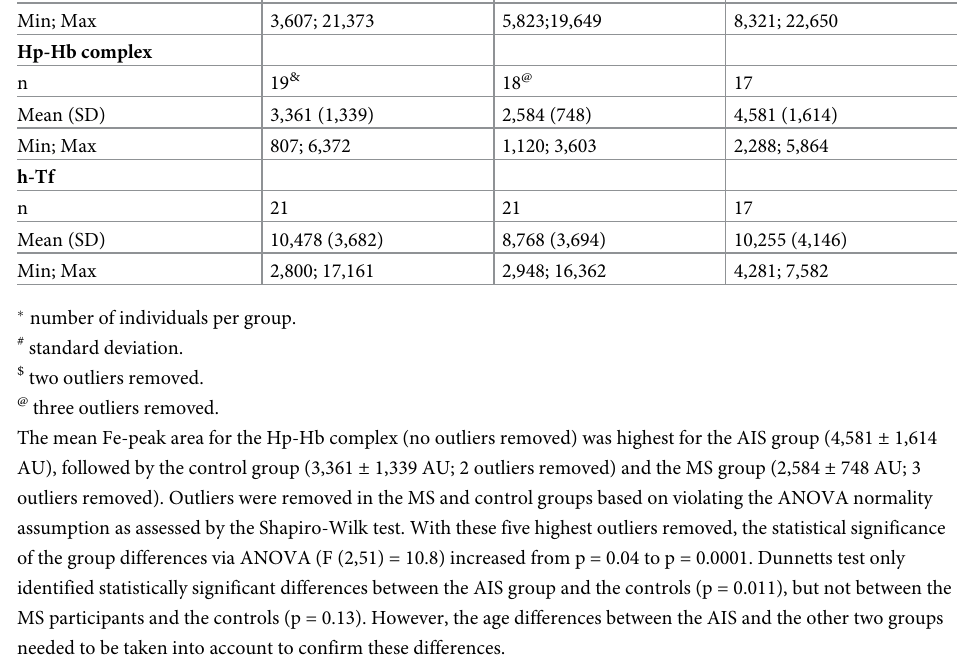
Table 2. Mean Fe values, standard deviations and minimum/maximum values obtained for the analysis of serum samples by SEC-ICP-AES for total Fe and peak areas for the Hp-Hb and the h-Tf peak. Peak Area Groups Control MS